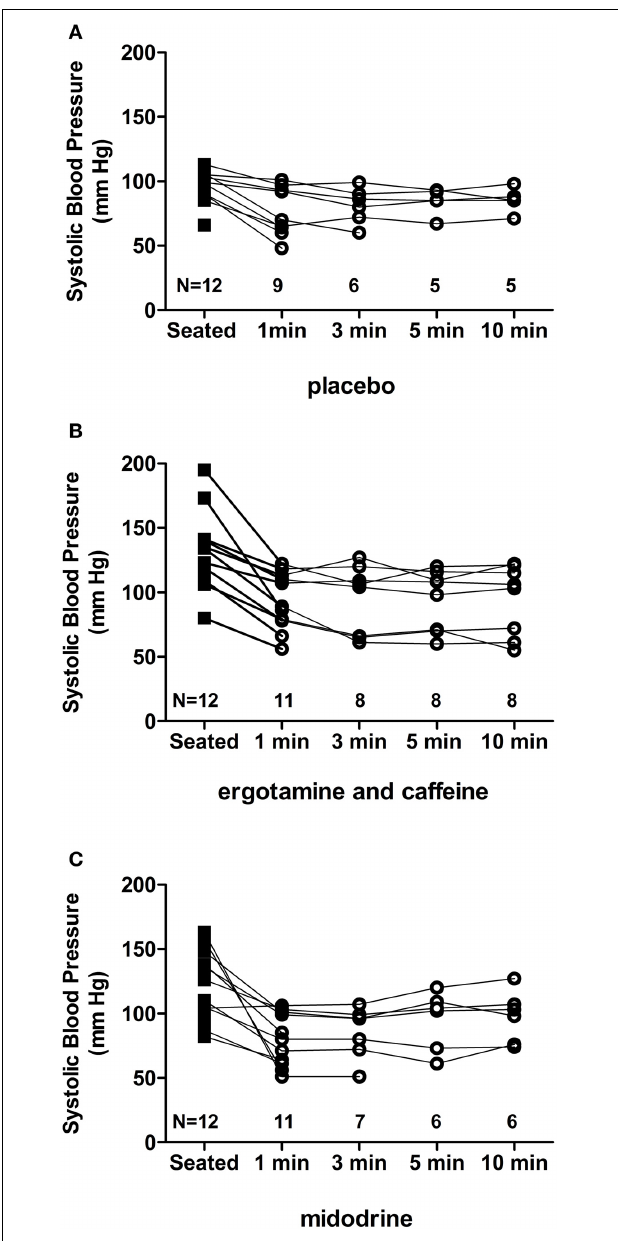
FIGURE 2 | Orthostatic tolerance following drug administration. At 60min following drug administration, autonomic failure patients were asked to stand for 10min, or as long as tolerated. Systolic blood pressure was measured at 1, 3, 5, and 10min to assess orthostatic tolerance. Blood pressure data and standing time are shown for each individual patient, with N representing the number of patients who could tolerate standing at a given time point. Five out of 12 (42%) patients could stand for 10min following placebo (A) compared with 8 out of 12 (67%) after ergotamine/ caffeine (B) and 6 out of 12 (50%) after midodrine (C) administration.